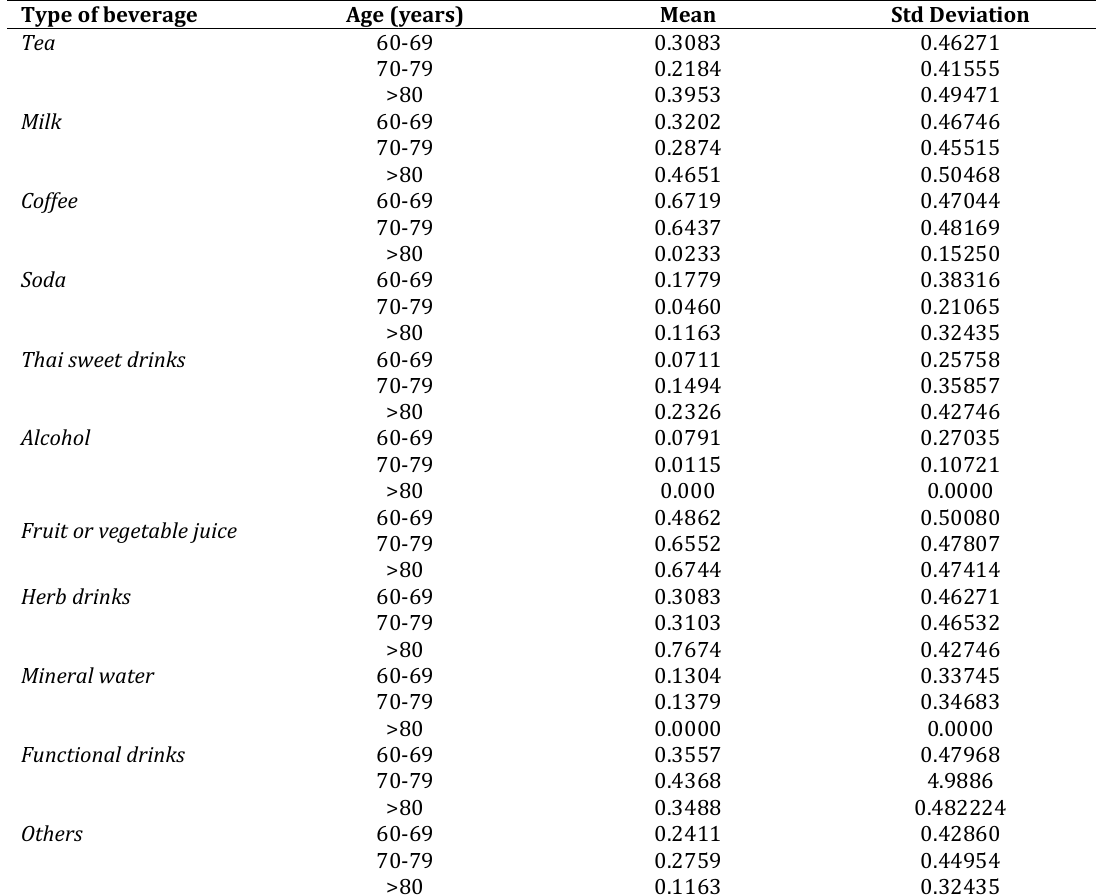
Table 2: Comparison between the types of drinks and the range of age